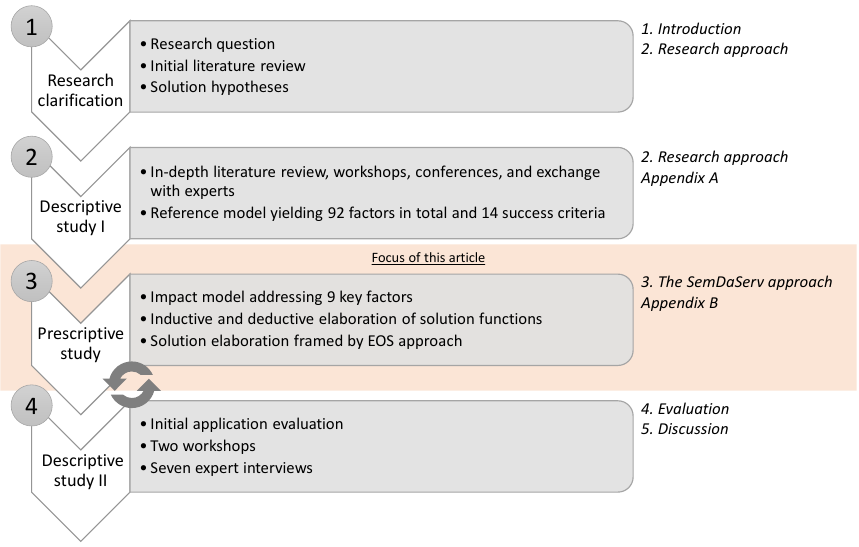
Figure 2. The research approach and focus of this